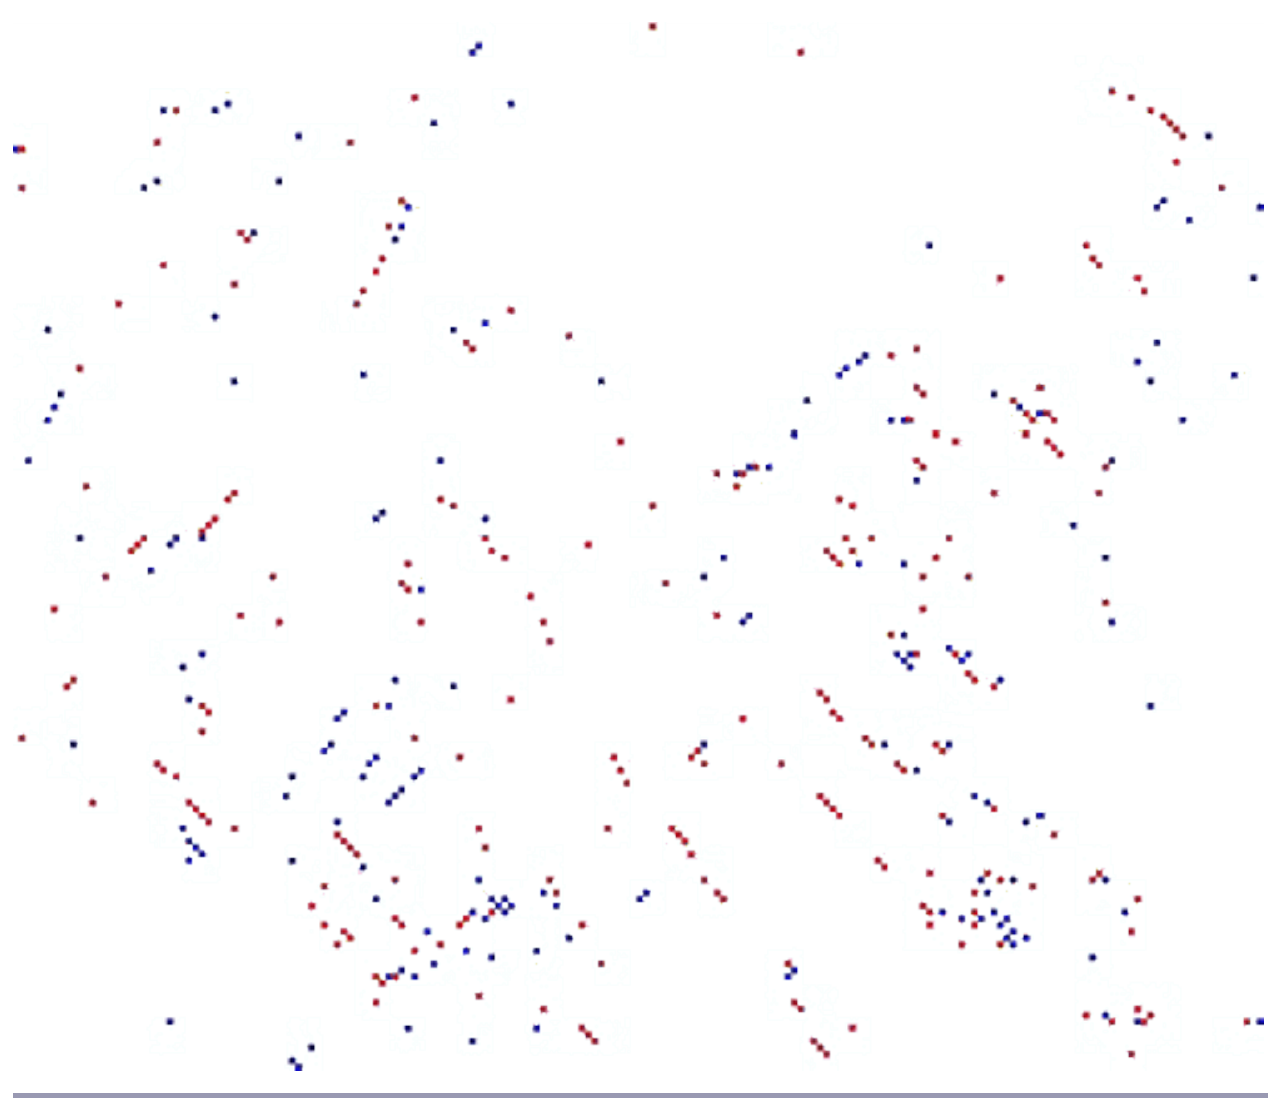
Fig. 7 . Cracks in the resistance layer representation of an 8000 ha area in the Resort Municipality of Whistler. Type 1 cracks are shown in red, and type 2 cracks are shown in